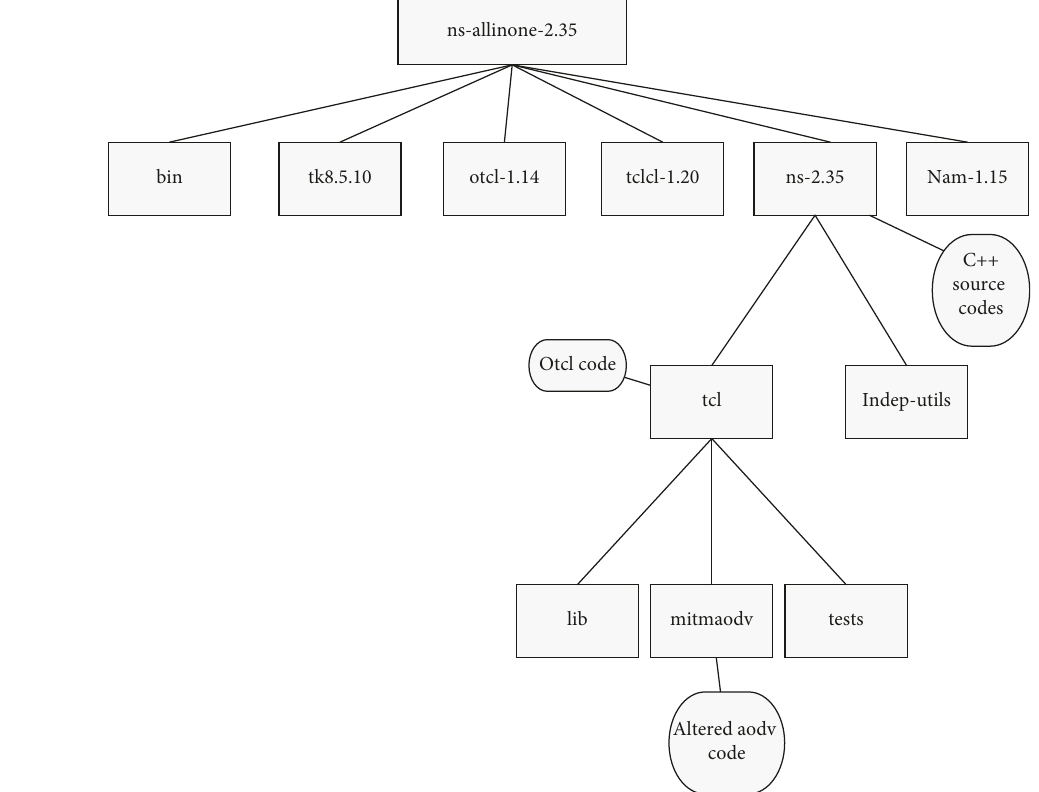
Figure 5: Revised directory structure of ns-allinone-2.35 package.